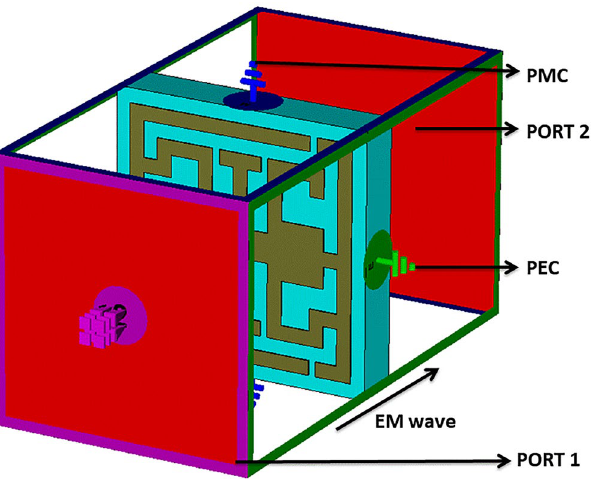
Figure 2. Anticipated structure with simulation setup (CST STUDIO SUITE 2019, https:// www. 3ds. com/ produ cts- servi ces/ simul ia/ produ cts/ cst- studio- suite) 30 .